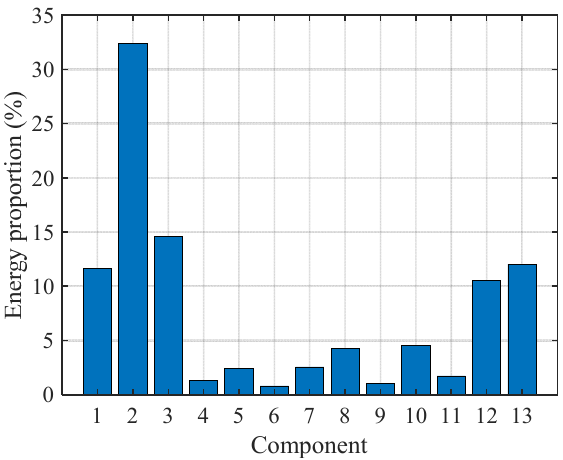
Figure 10. Energy proportion of each component obtained by EWT.